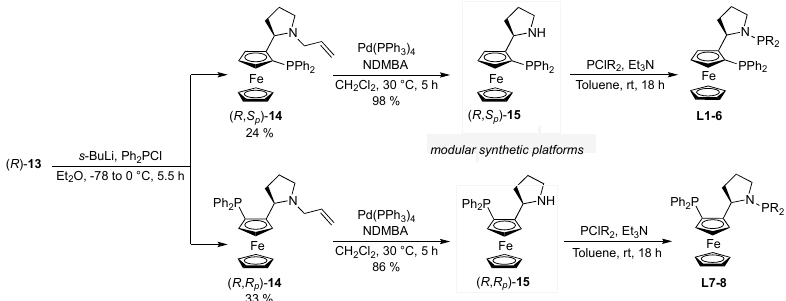
modular synthetic